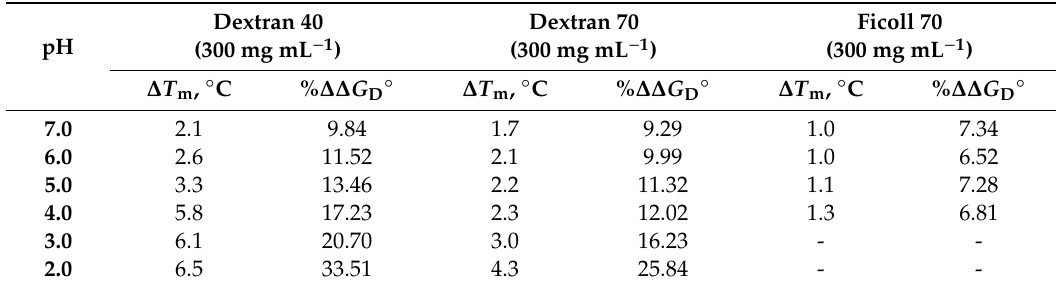
Table 4. Changes in stability parameters on transferring lysozyme from 0 mg mL -1 to 300 mg mL -1 of crowding agents and their comparison at di ff erent pH values a,b